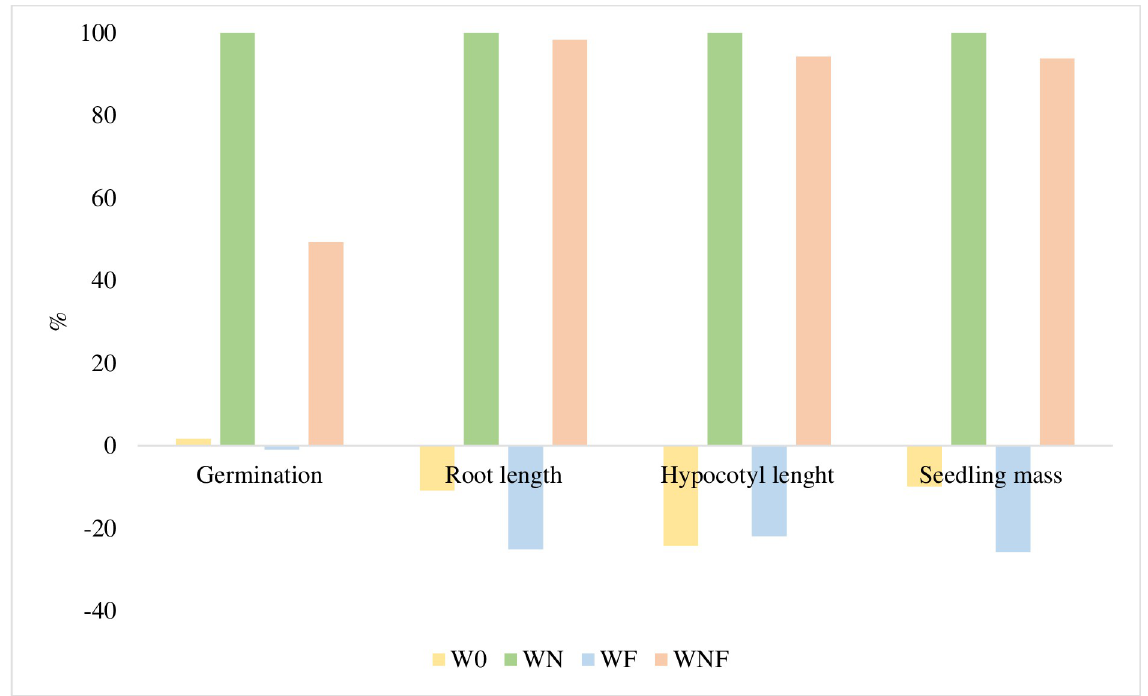
Fig 7. Inhibition (+) and stimulation (-) effect of extract from willow composting biomass in percentage of seedling and germination parameters collected at the II term compared to the control (mustard seeds germinated in distilled water).